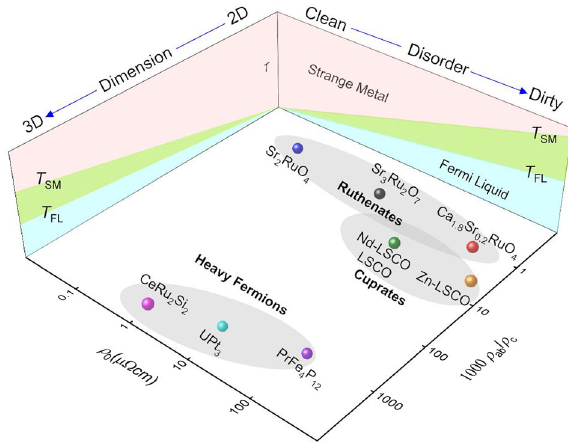
Fig. 3 Schematics of Fermi liquid properties versus disorder and dimensionality. High density of states (DOS) systems 4,5,11,16,17,31,64,65 plotted as a function of dimensionality and disorder gauged, respectively, by ρ ab / ρ c (in-plane resistivity over out-of-plane resistivity) and ρ 0 (from refs. 11,13,33,34,57,66 – 73 ). The third axis labeled T refers to temperature. For all systems the DOS are tuned to the Fermi level by tuning parameters such as magnetic fi eld or uniaxial pressure, and the values of ρ ab / ρ c and ρ 0 are taken at these critical tuning parameter whenever possible. For the cuprates the following abbreviations are used: LSCO: La 1.8 Sr 0.2 CuO 4 , Nd-LSCO: La 1.36 Nd 0.4 Sr 0.24 CuO 4 , Zn-LSCO: La 1.82 Sr 0.18 Cu 0.96 Zn 0.04 O 4 . The vertical thermal axis indicates the two temperature scales T FL and T SM expected within a van Hove singularity scenario. T FL is the Fermi liquid cutoff temperature and above T SM strange metal behavior dominates. 2D and 3D denote two-dimensional and three-dimensional systems,